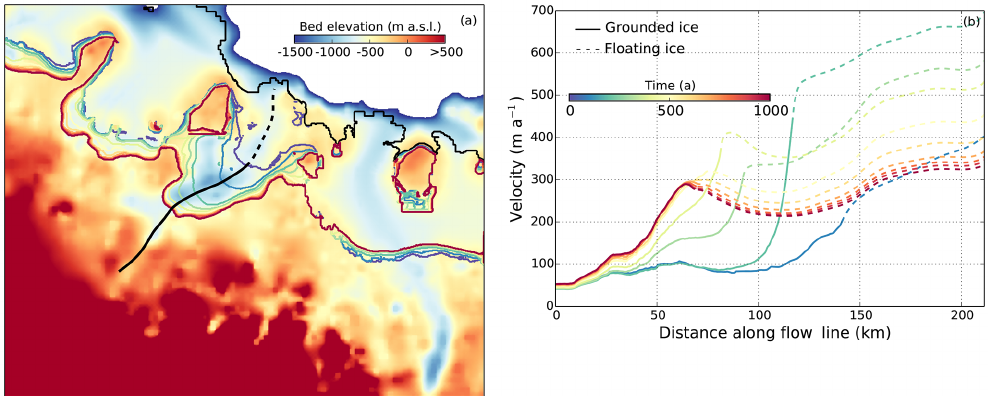
Figure 6. Grounding-line migration for the B e /S/L/M b1 /A m experiment. (a) The bed elevation is in the background, grounding lines are shown every 100 years (colour scale shown in b ), and the dashed line shows the central flow line of HB. (b) Ice velocity profiles along the central flow line of HB, shown every 100 years. The grounding-line position is marked by the limit between solid and dashed parts of profiles.